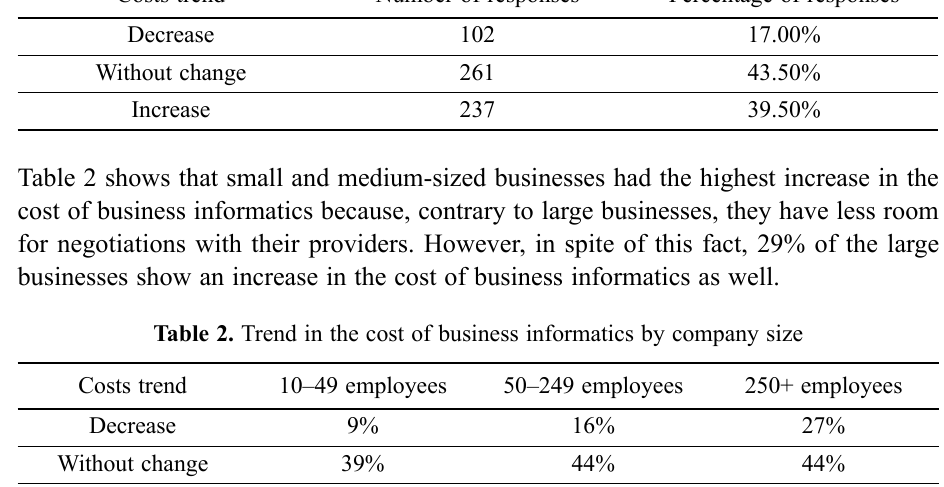
Table 1. Trend in the cost of business informatics in analyzed companies Costs trend